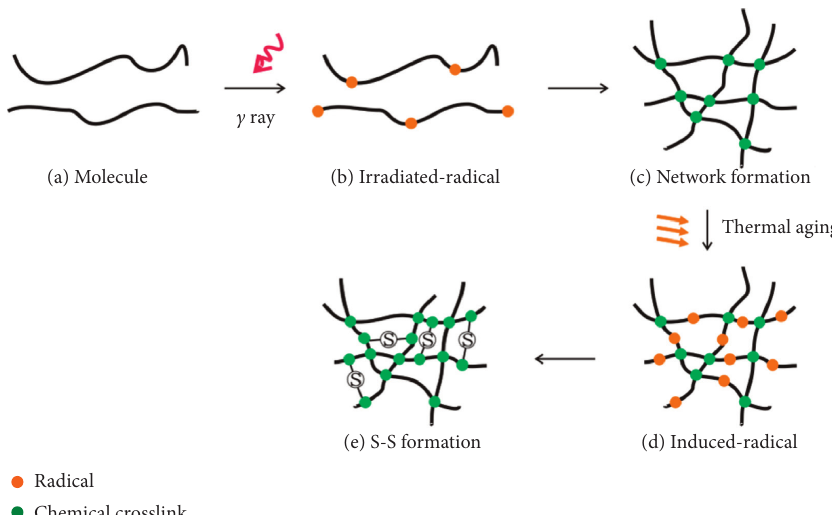
Figure 8: The reaction mechanism of rubber c -irradiated molecule with thermal